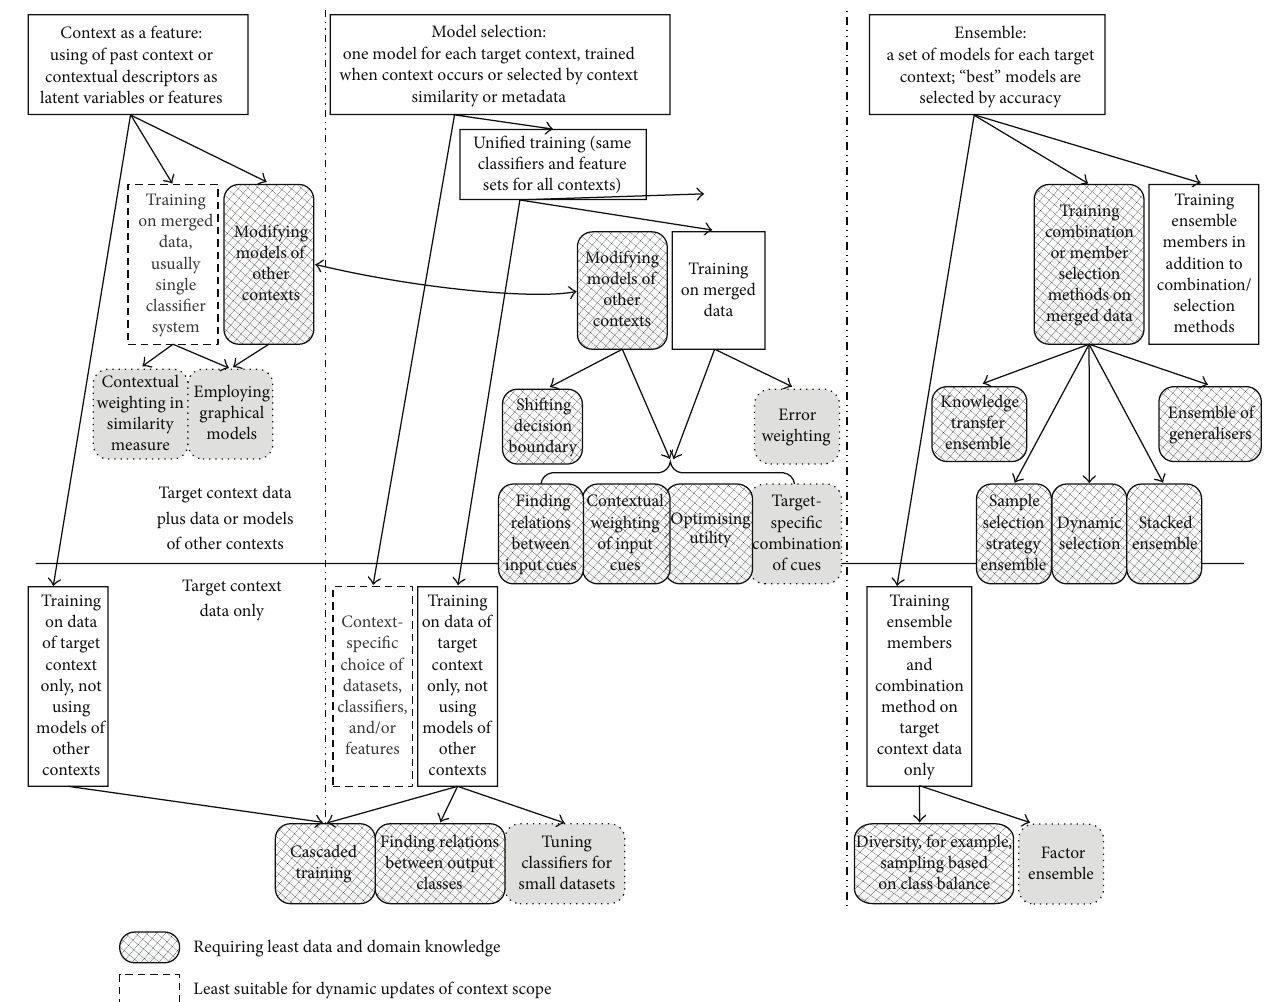
Figure 2: Lightweight adaptation